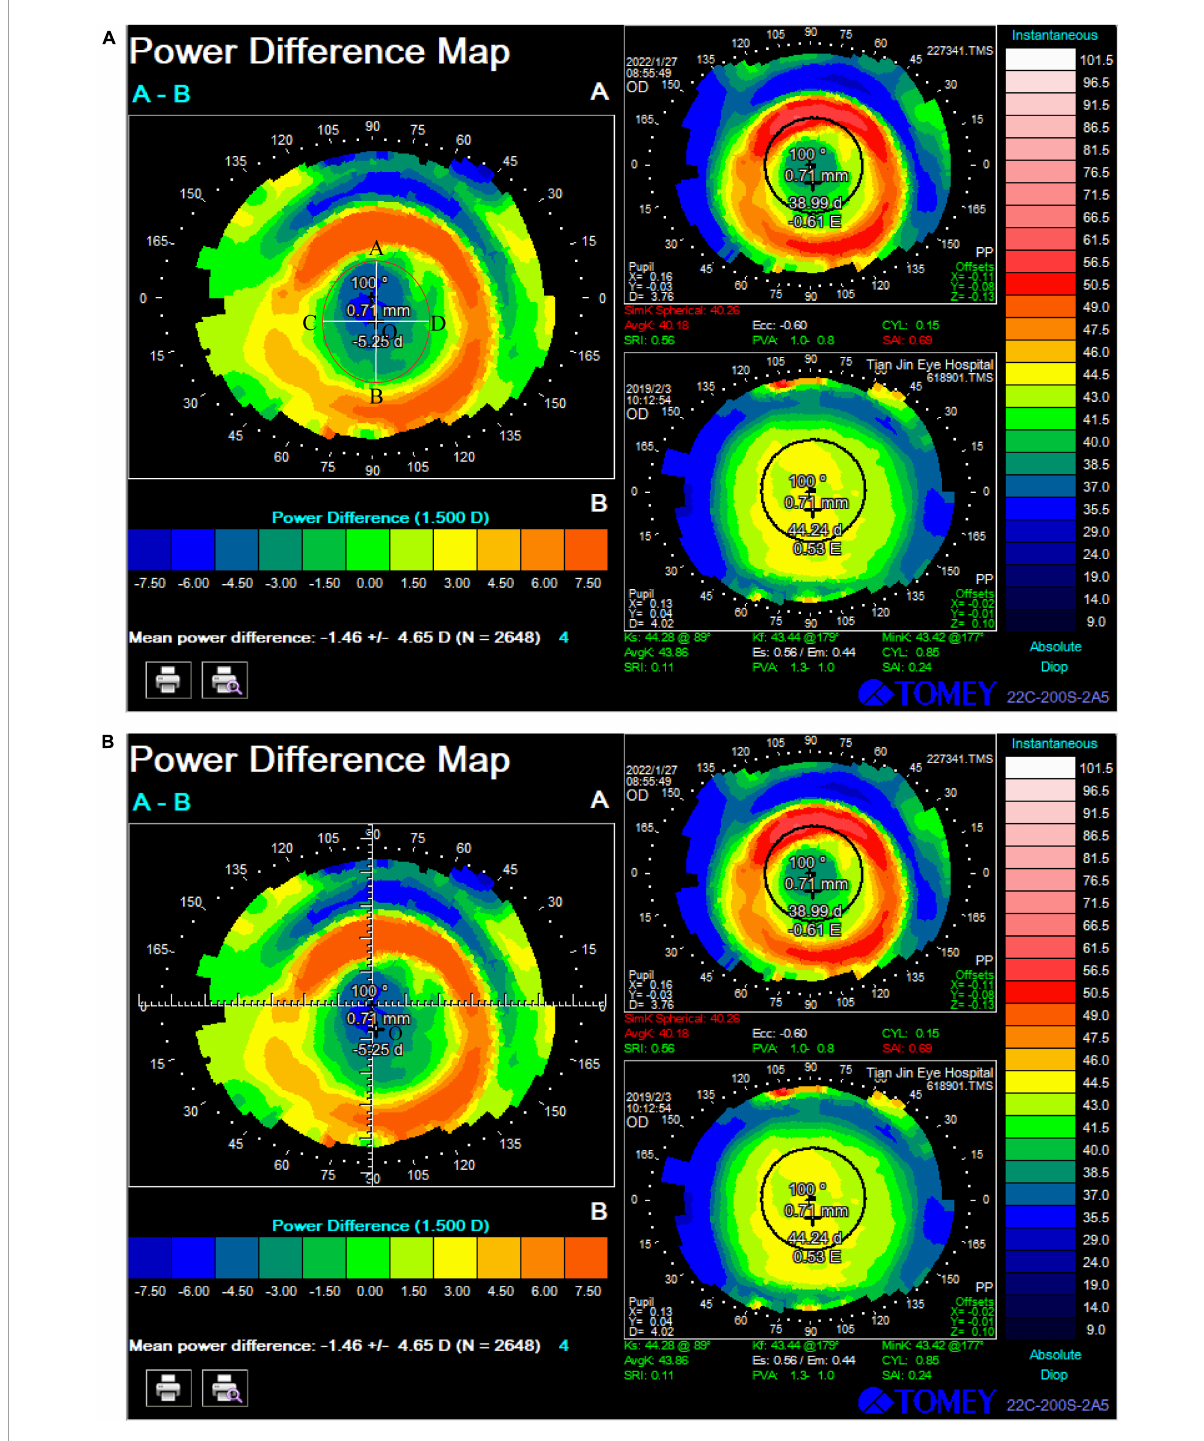
FIGURE1 Calculation method of treatment zone decentration: (A) Decentration distance: the area surrounded by the red circle is the treatment zone; line segments AB and CD were the horizontal and vertical diameters of the treatment zone; O point was the central point of the treatment zone. The distance from O point to the center of the pupil is 0.71 mm. (B) The position of the central point of the treatment zone (O point) on the coordinate axis: the pupil center was taken as the origin, and the horizontal ( X )-axis and vertical ( Y )-axis were set up. The decentration angle of O point was displayed by the topographic map software, which was 100 ◦ , The treatment zone decentration along X -axis and Y -axis was calculated as follows: X = cos 100 × 0.71, Y = –sin 100 ×